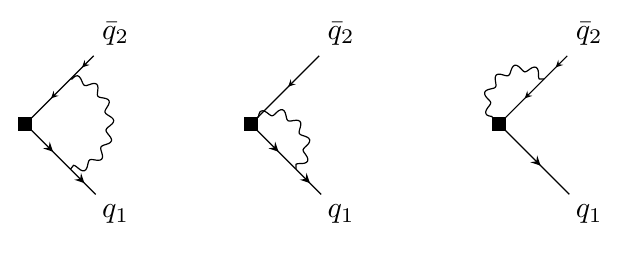
Figure 1 . Diagrams that contribute to the renormalization of the operator (2.4) at O ( α em )